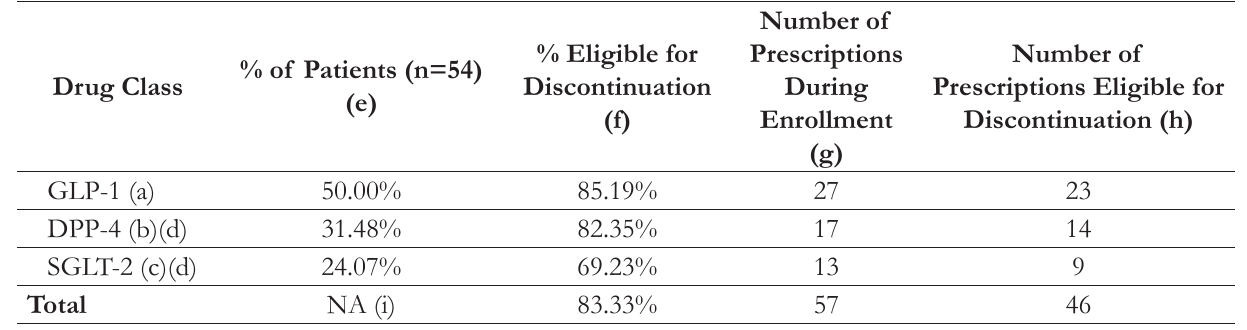
Table 1. Patients Prescribed and Taking Expensive Medications but Eligible for Discontinuation